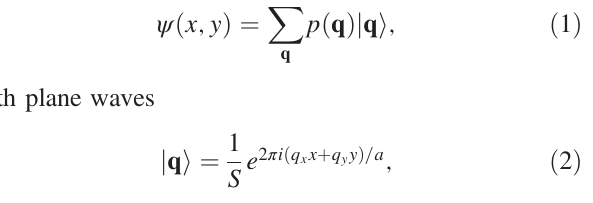
FIG. 2. Imaging of molecular wave functions via momentum- space mapping. The first row shows the momentum density in two dimensions, the second row the momentum wave function after phase retrieval, the third row the density (the sign of the wave function is indicated), and the fourth row the isosurface of ffiffiffi p b the three-dimensional wave function for (cid:2) 0 . 45 =a . (a) Theo- retical calculation for the lowest orbital ( n ¼ 1 ) of the artificial benzene molecule. (b) Simulated time-of-flight measurements with 1000 observed momenta in the x - y plane (randomly ffiffiffiffiffiffiffiffiffiffiffiffi p distributed) for the orbitals n ¼ 1 and (c) n ¼ 12 . (d) The ρ (second row). Since ð q Þ momentum density in y - z direction with 100 random momenta p for the lowest p orbital ( n ¼ 19 ), integrated momentum wave z function and density in z direction. In combination with the reconstructed wave function in x - y coordinates [see (b)], this allows one to retrieve the three-dimensional wave function for the lowest p orbital [analogous for (b) and (c) using the lowest z Wannier orbital in z